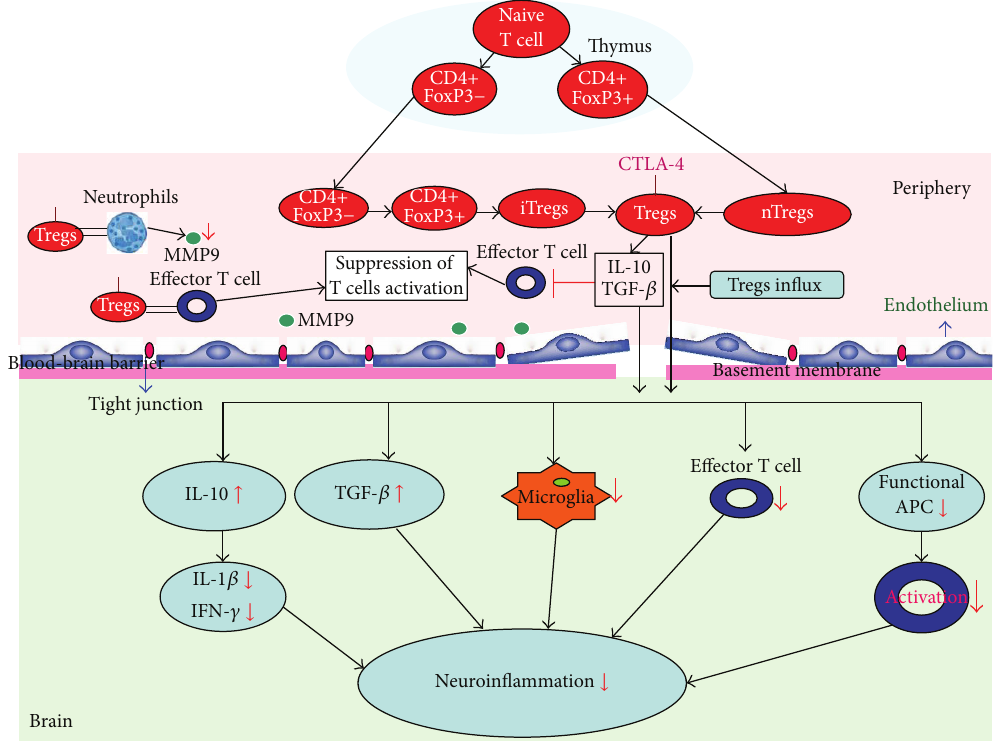
Figure 1: FoxP3 + CD25 + CD4 + Tregs in the pathogenesis of stroke. Both natural and induced FoxP3 + CD25 + CD4 + Tregs migrate into the brain parenchyma after stroke. The functional roles of FoxP3 + CD25 + CD4 + Tregs in modulation of neuroinflammation after stroke, including (1) secreting anti-inflammatory cytokines to decrease proinflammatory cytokines in periphery and brain, such as transforming growth factor- 𝛽 (TGF- 𝛽 ) and interleukin-10 (IL-10); (2) reducing Matrix metallopeptidase 9 (MMM-9) to prevent blood-brain barrier disruption; (3) suppressing effector T cell both in periphery and brain; (4) inhibiting the activation of microglia. FoxP3 + CD25 + CD4 + Tregs suppress the detrimental inflammatory responses after